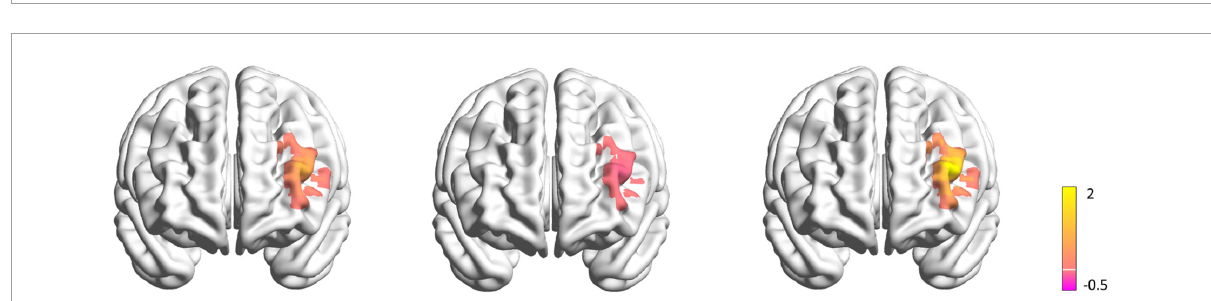
FIGURE4 Maps of the left DLPFC activation difference before and after stimulation during VFT task in 50% RMT condition (left) , 70% RMT condition (middle) , 100% RMT condition (right) . The color bar indicates the t -values render over on a 3D head model. The yellow color represents less (cid:49) HbO after stimulation, while the purple color represents more (cid:49) HbO after stimulation.